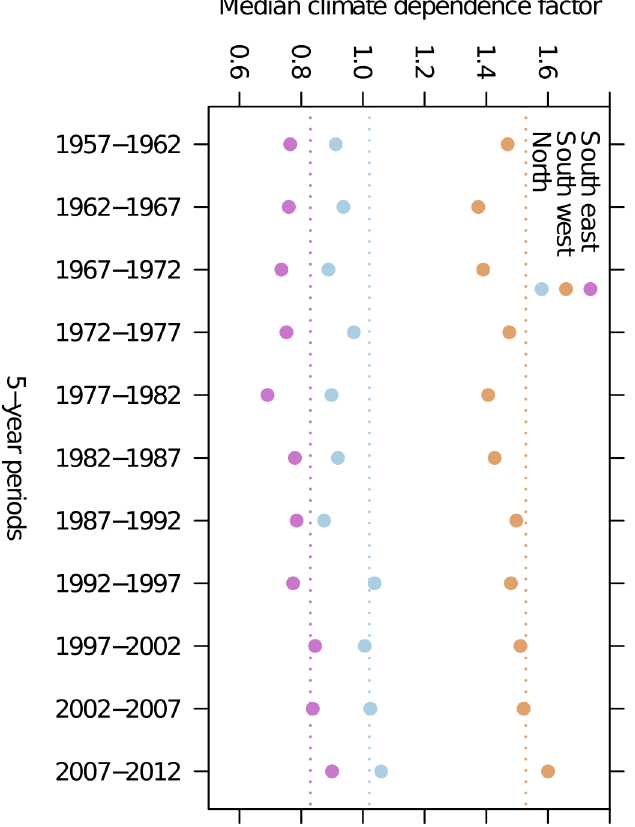
Fig 7. Regional climate dependence factors over time. All three regions showed an increase in climate dependence factors since 1960 (medians by 5-year periods, based on 5-year mean climate). The broken lines indicate, for each region, the median climate dependence factor using constant plot climate 1991 –